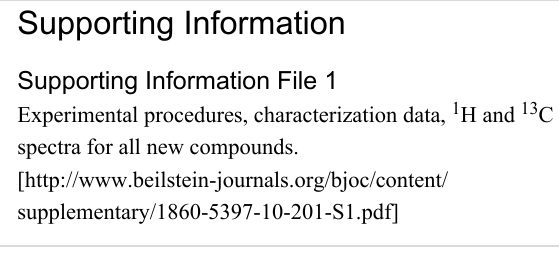
metathesis reactions and are unreactive, the corresponding allyl esters show significantly improved reactivity. The improved re- activity is attributed to relay step in the cross metathesis reac- tion